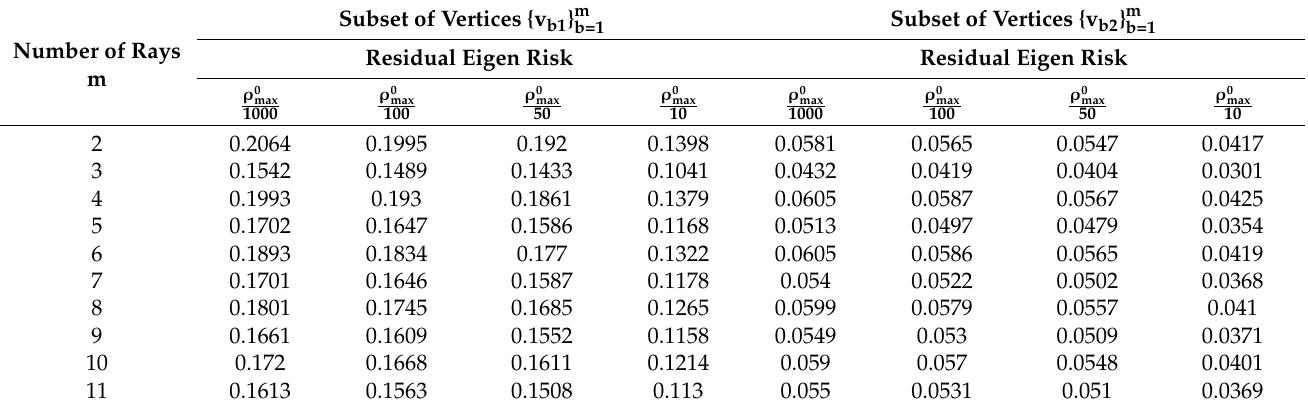
Table 4. Numerical estimates of the relative error of solving the problem of the optimal placement of elements in subsets of vertices of the attack structure at a given threshold of residual risk; rounding is to the fourth digit with